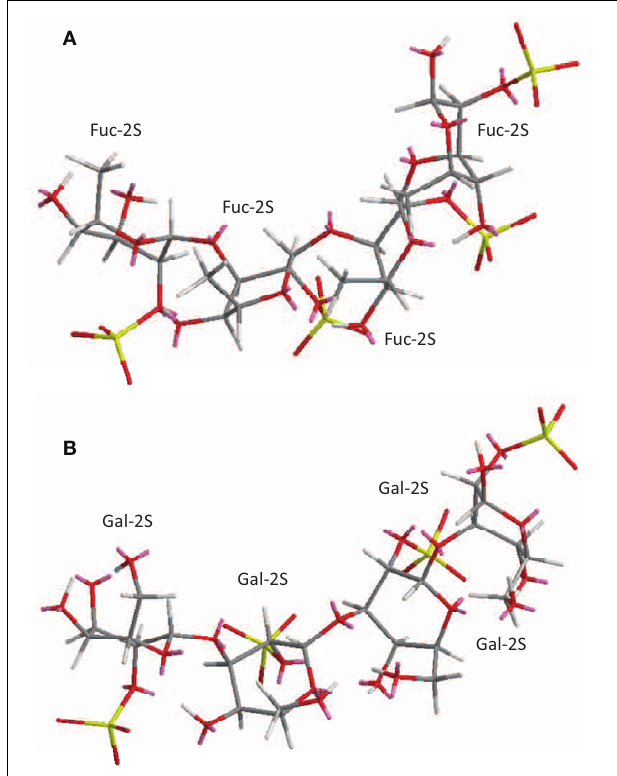
FIGURE 2 | 3D structural representation of the sea-urchin 3-linked 2-sulfated glycans: (A) sulfated fucan (SF) from Strongylocentrotus franciscanus , and (B) sulfated galactan (SG) from Echinometra lucunter both shown at their tetrasaccharide models. These pictures represent the lowest-energy conformations obtained by computational simulation on Chem3D Ultra 8.0 software using 10,000 step intervals of 2.0 fentosecond each, at 298K and heating/cooling rate of 1000Kcal/atom/ps. The polymers are made of the following structures (A) [ → 3)- α -L-Fuc p -2(OSO − 3 )-(1 → ] n (Alves et al., 1997) for sea-urchin S. franciscanus , and (B) [3)- α -L-Gal p -2(OSO − 3 )-(1 → ] n (Vilela-Silva et al., 1999) for sea-urchin E. lucunter . Gal p and Fuc p stand for galactopyranosyl and fucopyranosyl units, respectively. Carbon (C), oxygen (O), hydrogen (H), and sulfur (S) atoms are represented in gray, red, white, and yellow. They have not been indicated because of the big conformational overlap. The unpaired electrons of oxygens are shown in